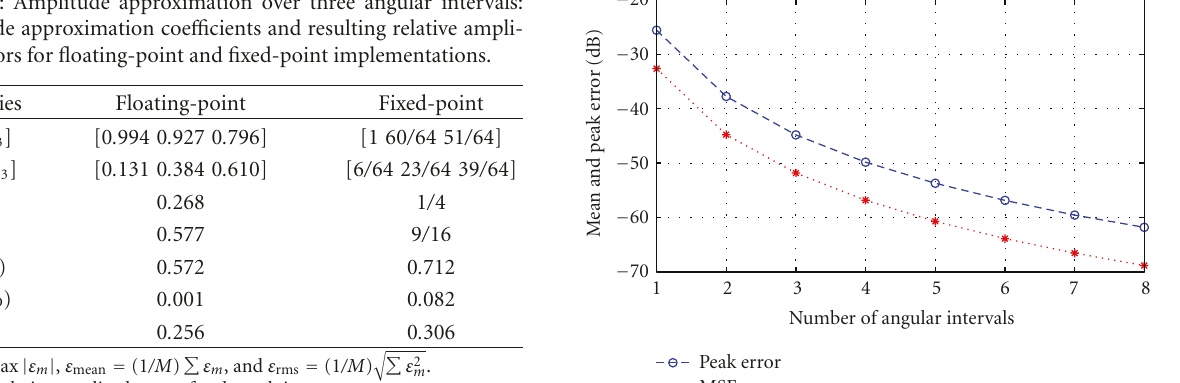
Table 2: EVM and ACLR performances of an LUT predistorter with amplitude versus power indexing; the input is WCDMA.